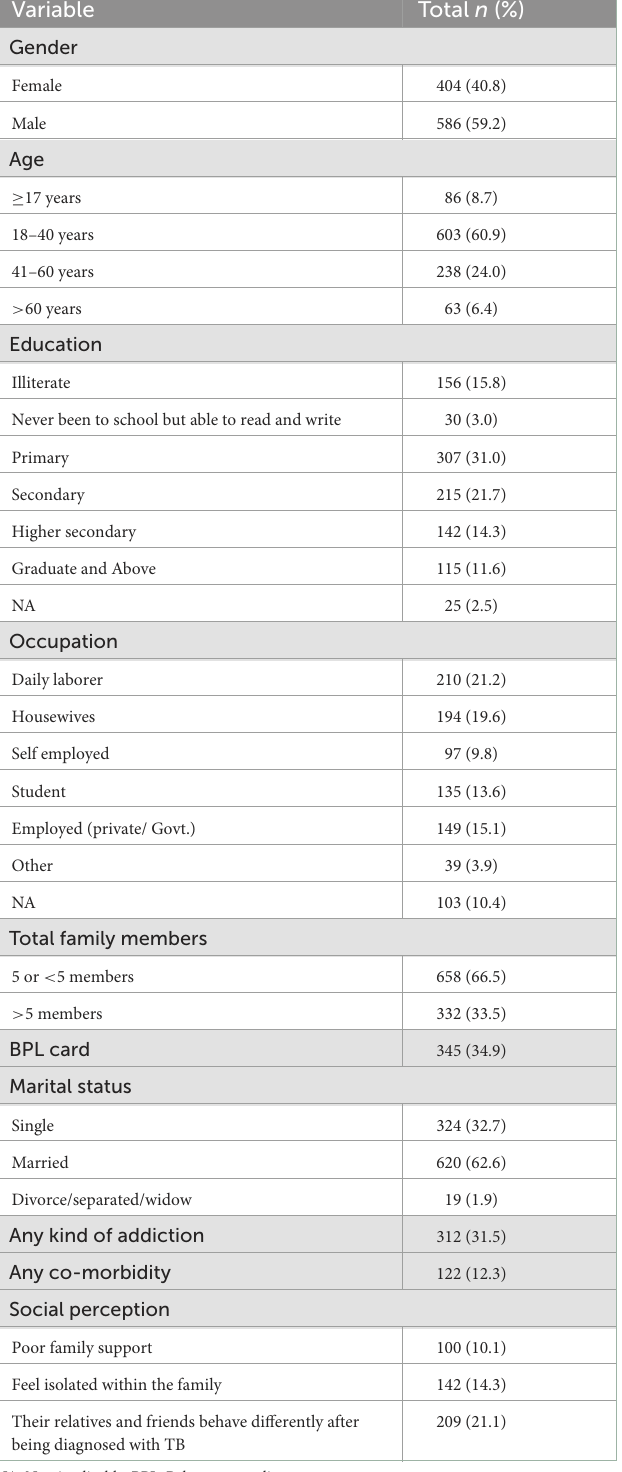
TABLE 1 Characteristics of the TB patients participated in the study ( N = 990).